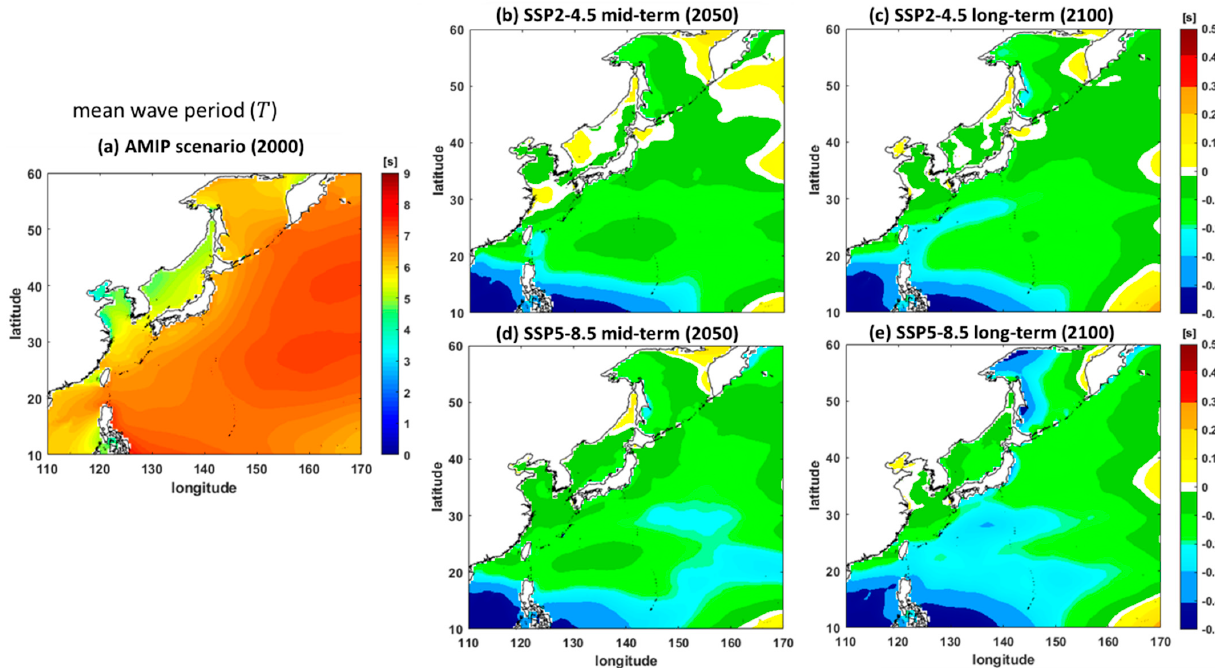
Figure 5. Mean wave period ( 𝑇 in seconds) results for ( a ) the AMIP scenario result for 2000 and the differences between the results of future scenarios and the AMIP scenario: ( b ) SSP2-4.5 medium-term, ( c ) SSP2-4.5 long-term, ( d ) SSP5-8.5 medium-term, and ( e ) SSP5-8.5 long-term scenarios.